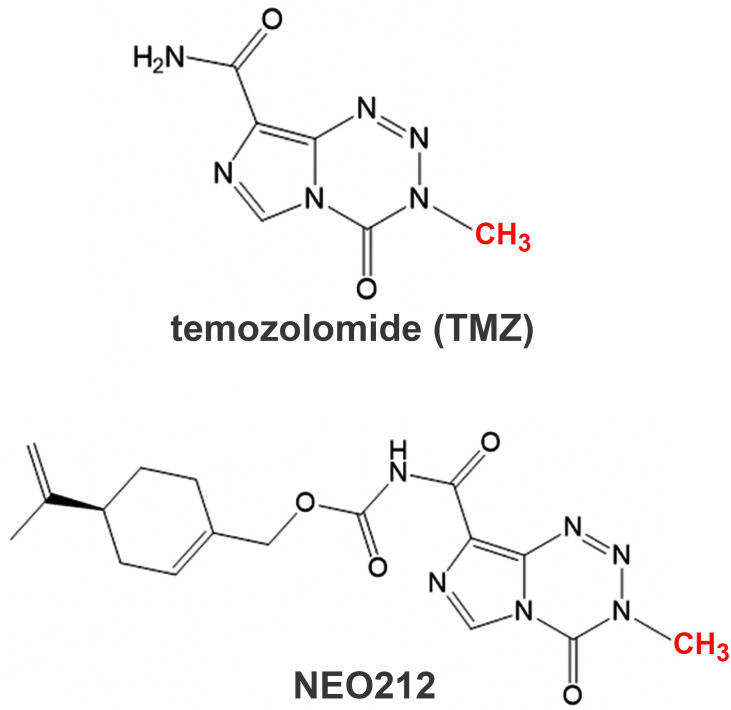
The chemical structures of TMZ and NEO212.TMZ was conjugated with perillyl alcohol via a carbamate bridge to generate NEO212. The derivatization of TMZ with perillyl alcohol creates a new chemical entity with new physicochemical properties but presumably retains the same alkylating properties of TMZ. This is because NEO212 breaks down to release intact TMZ and therefore the same methyl group (in red) in NEO212 as in TMZ will eventually be donated by NEO212 to DNA nucleobases via the release of the same highly reactive methanediazonium chemical species.